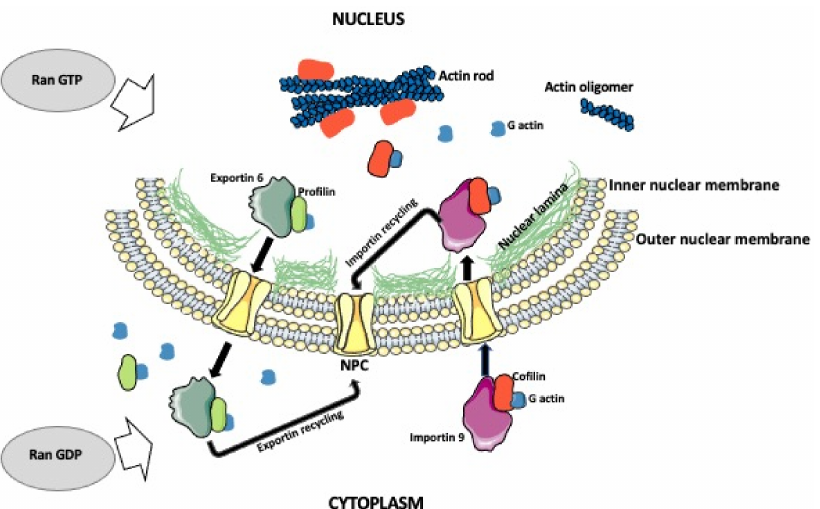
Figure 1. Nuclear actin shuttling and actin rode formation. Actin monomers in the cytoplasm form a complex with cofilin and importin 9. The complex is imported into the nucleus, where actin is released, and the importin is cycled back to the cytoplasm. The monomeric nuclear actin can form oligomers, polymers, or actin rods. The export of the actin from the nucleus is facilitated by the profilin and exportin 6. While in the cytoplasm, exportin is recycled back into the nucleus. This process depends on the balance between nuclear and cytoplasmic Ran GTP/GDP. Ran GTP promotes nuclear export and Ran GDP promotes nuclear